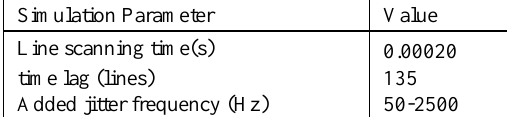
Figure 2. Reference image